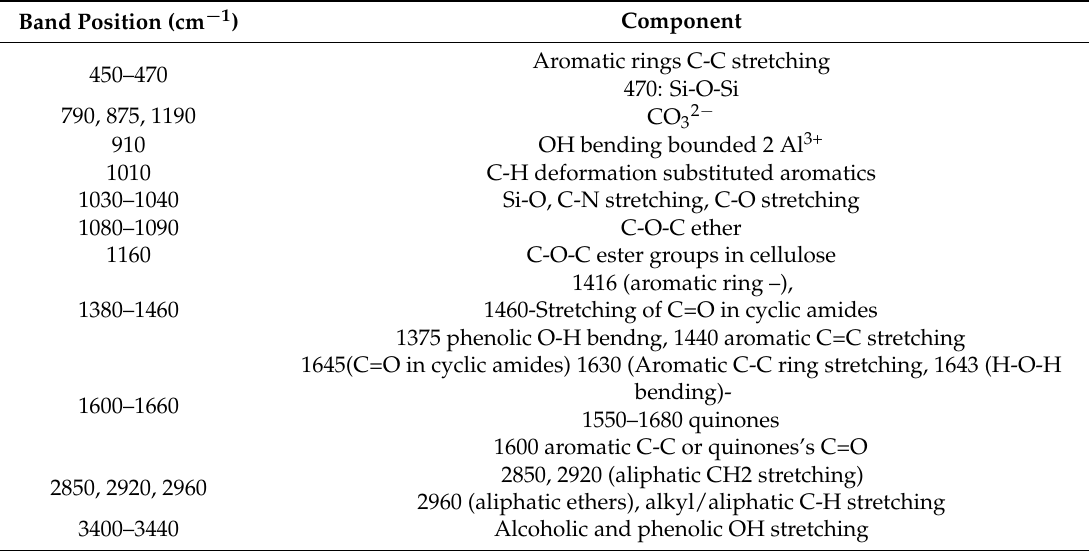
Table 5. Assignments of each FT-IR peak